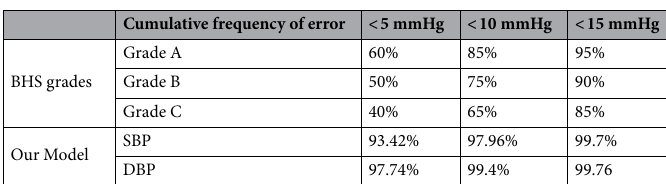
Table 2. Evaluation of the Concat_CNN approach based on BHS standard.